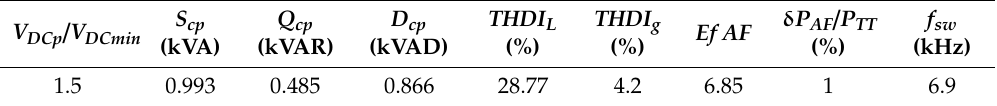
Table 2. The main energetic performances of the adaptive control, at reduced load.